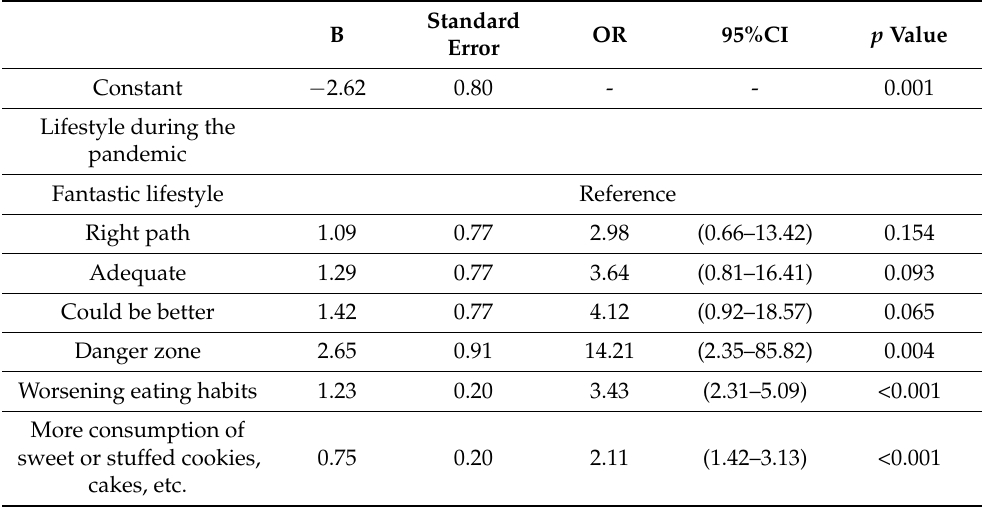
Table 4. Multivariable logistic regression model for predicting ≥ 5% self-reported body weight gain during